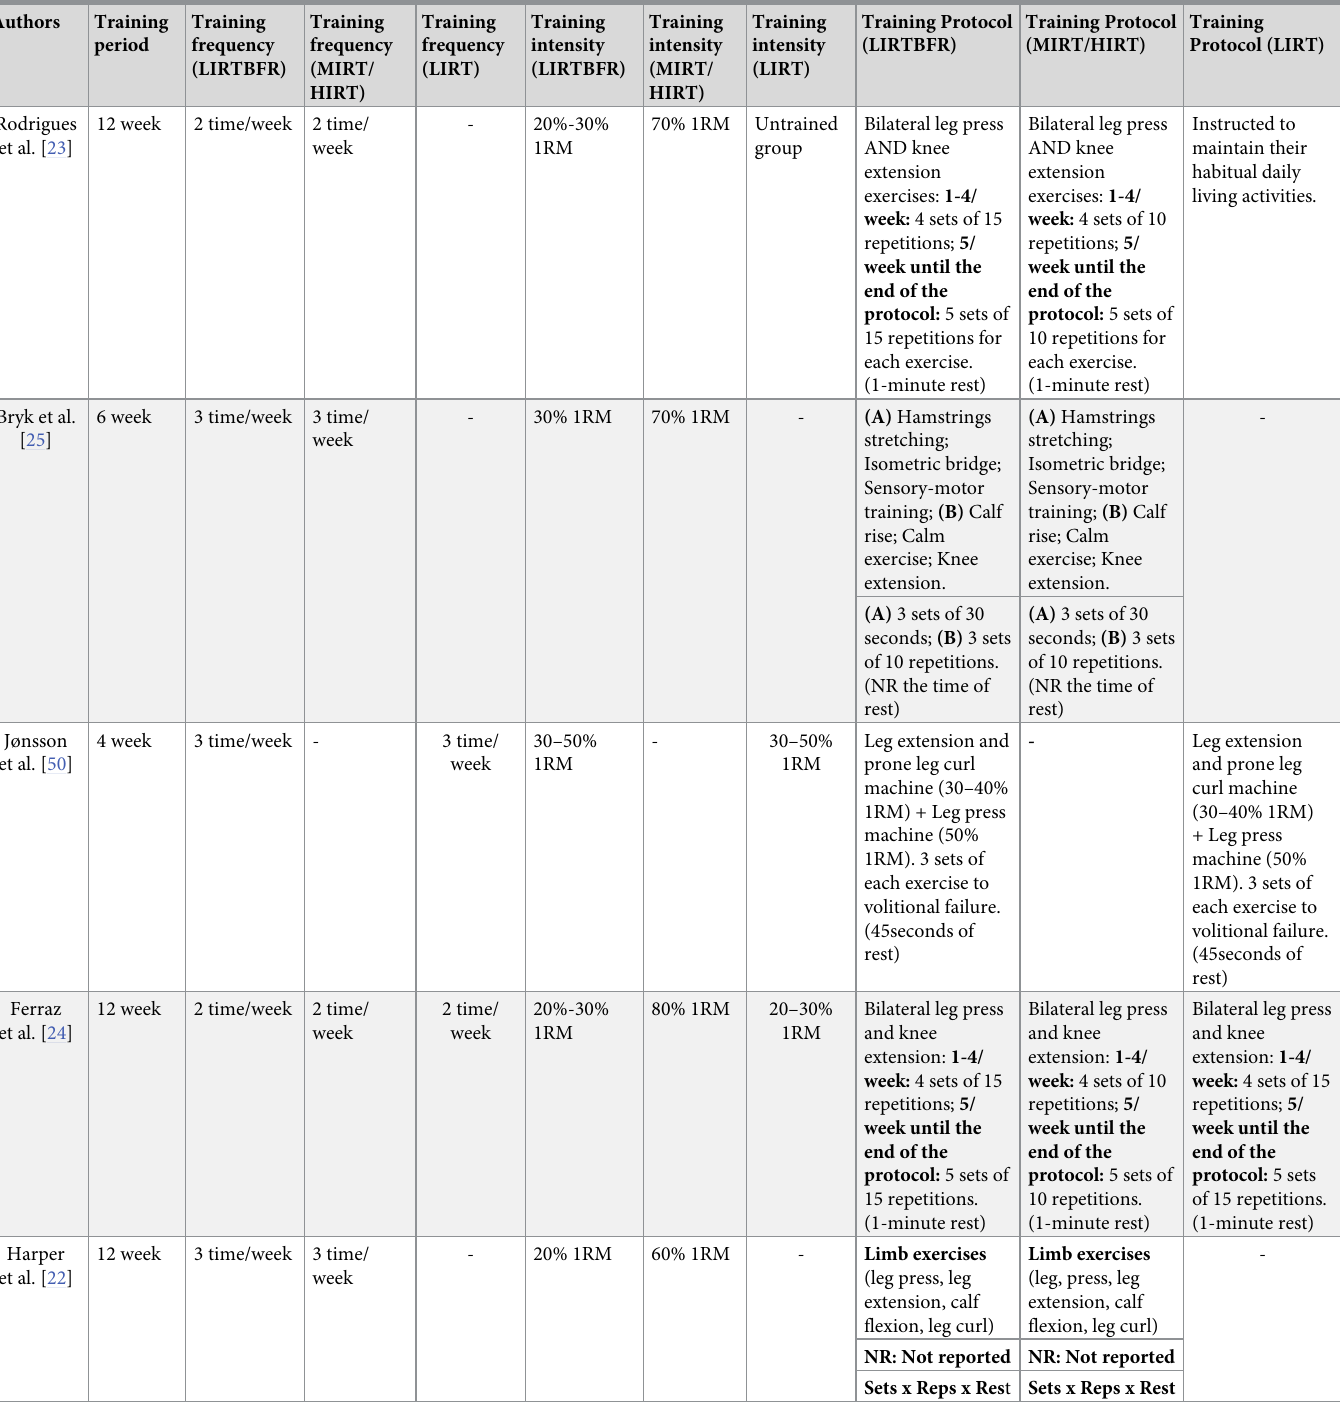
Table 2. Training methodology of the included studies.